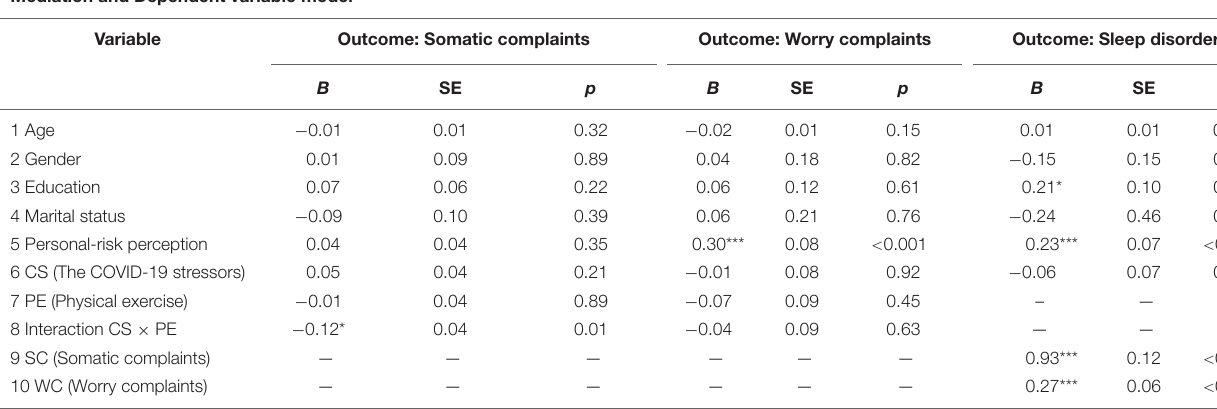
TABLE 2 | Moderated mediation analysis. Mediation and Dependent variable